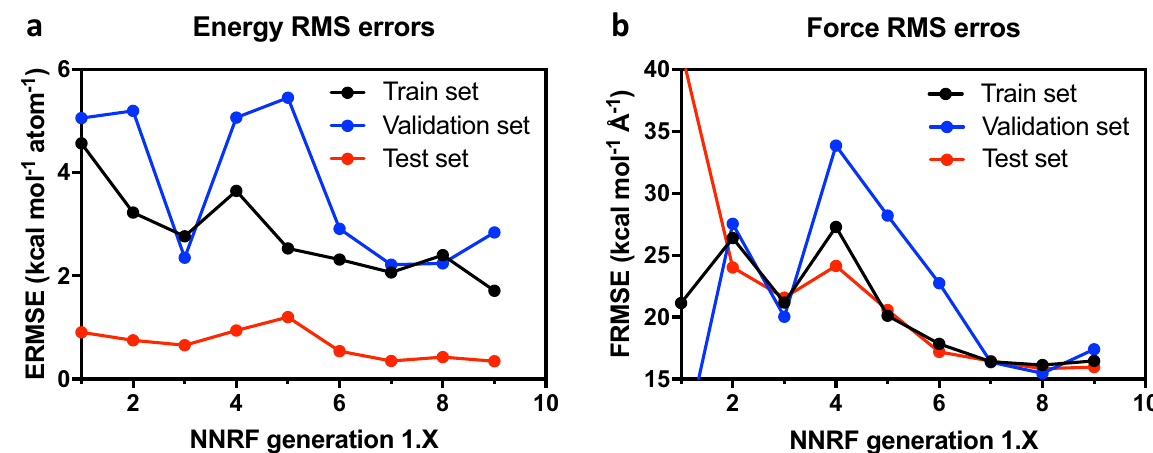
Fig. 3 The RMS errors of different data sets vs. NNRF generation. The energy RMS error (ERMSE) in ( a ) and the force RMS error (FRMSE) in ( b ) from Gen1.1 to Gen1.9 NNRF for three datasets (Training set, Validation set, and Testing set). The ERMSE and FRMSE for a single iteration (Gen1.7 NNRF) can be found in Supplementary Fig. 5.